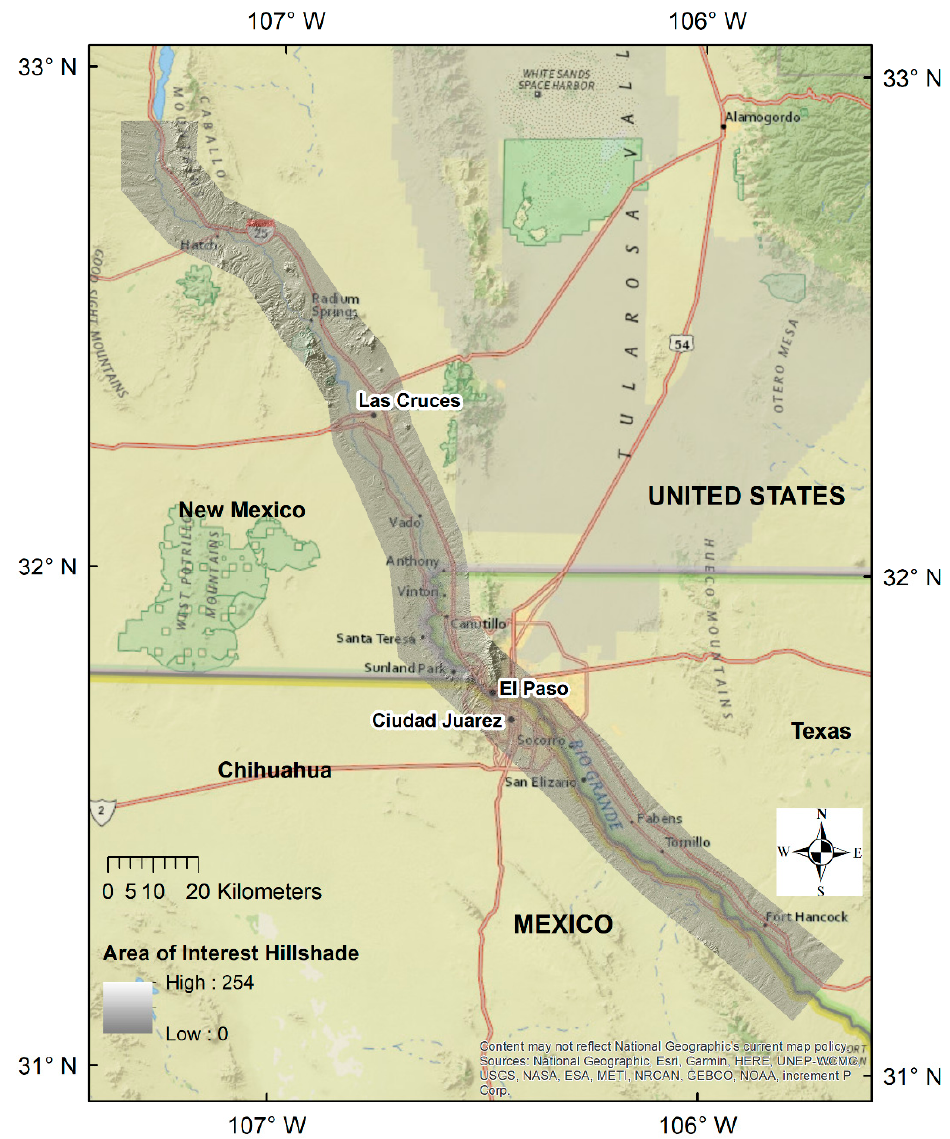
Figure 1. The study area showing the region of interest delineated by a hillshade.